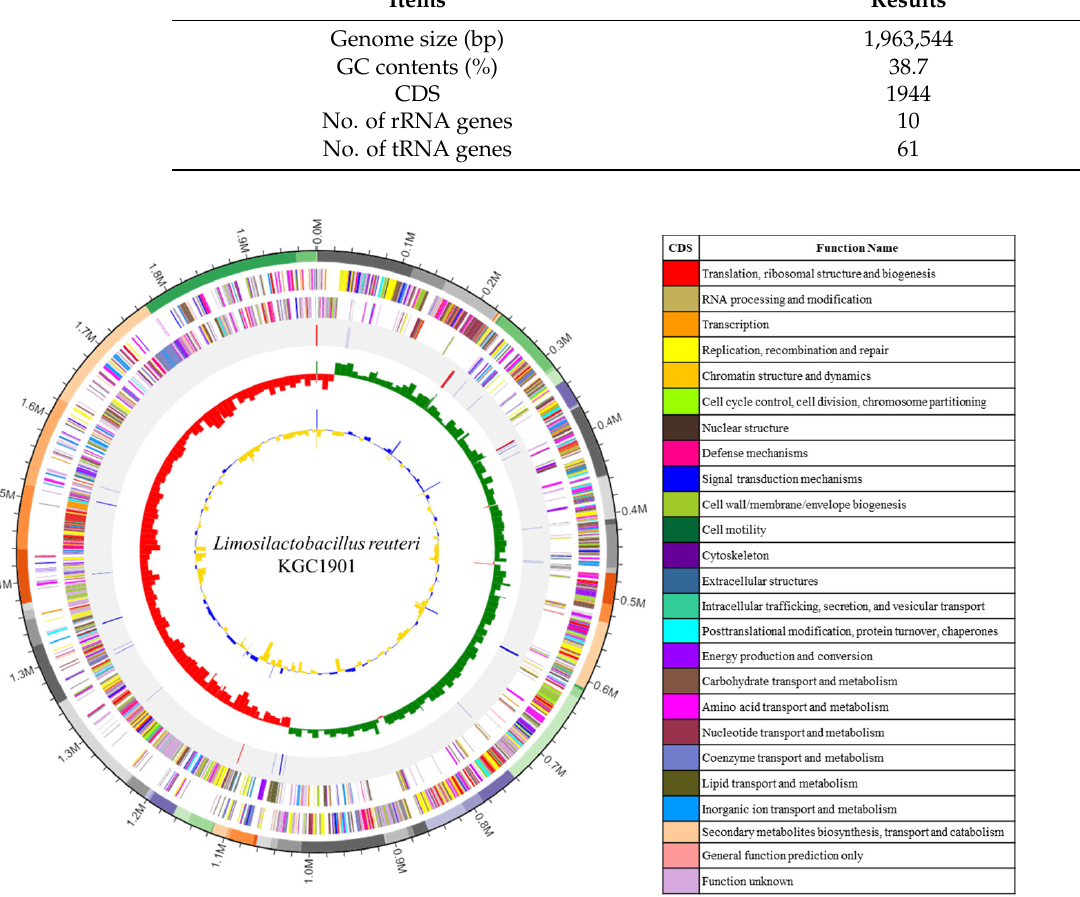
Figure 2. Genome map of L. reuteri KGC1901. From outside to the center: 71 contigs, annotated reference genes (specifically, CDSs) found in the forward strand; in the reverse strand, rRNA and tRNA found in this genome; GC skew metric (higher-than-average values: green, lower-than-average values: red); and GC ratio metric (higher-than-average values: blue, lower-than-average values: yellow).